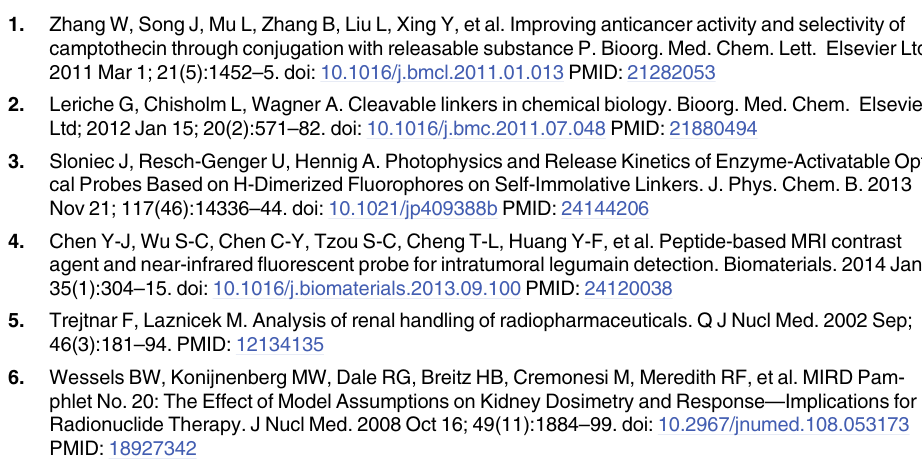
S1 Table. Amino acid sequences of the peptides used in this work. S2 Table. Biodistribution of 111 In-labelled peptides in CD1 nu/nu mice with CHL-GLP1R positive tumour xenografts. Values are mean percentages injected dose per gram tissue ( n = 4. Error bars SD). Blocking was performed by pre-injection of 100 μ g excess of unmodified exendin-4. Mice were sacrificed 4 h after injection. S3 Table. Biodistribution of the 111 Inlabelled fragments of the corresponding peptides in CD1 nu/nu